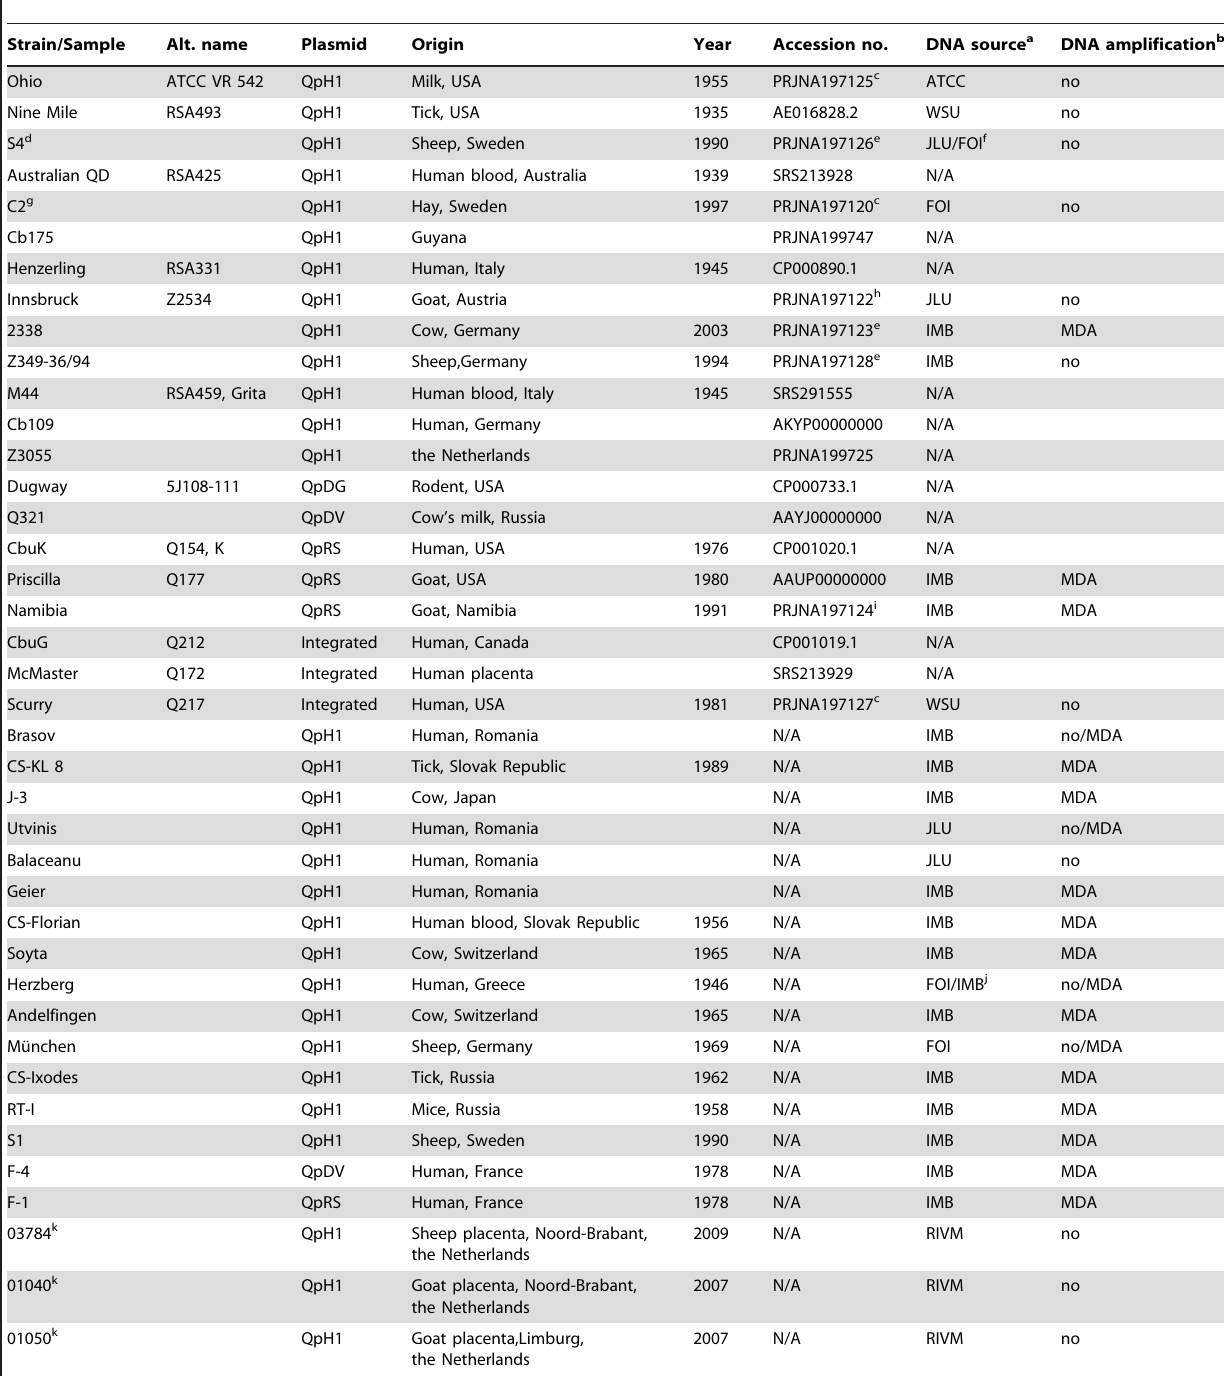
Table 1. The 21 genomes, 26 isolates and three tissue samples analyzed in this study.